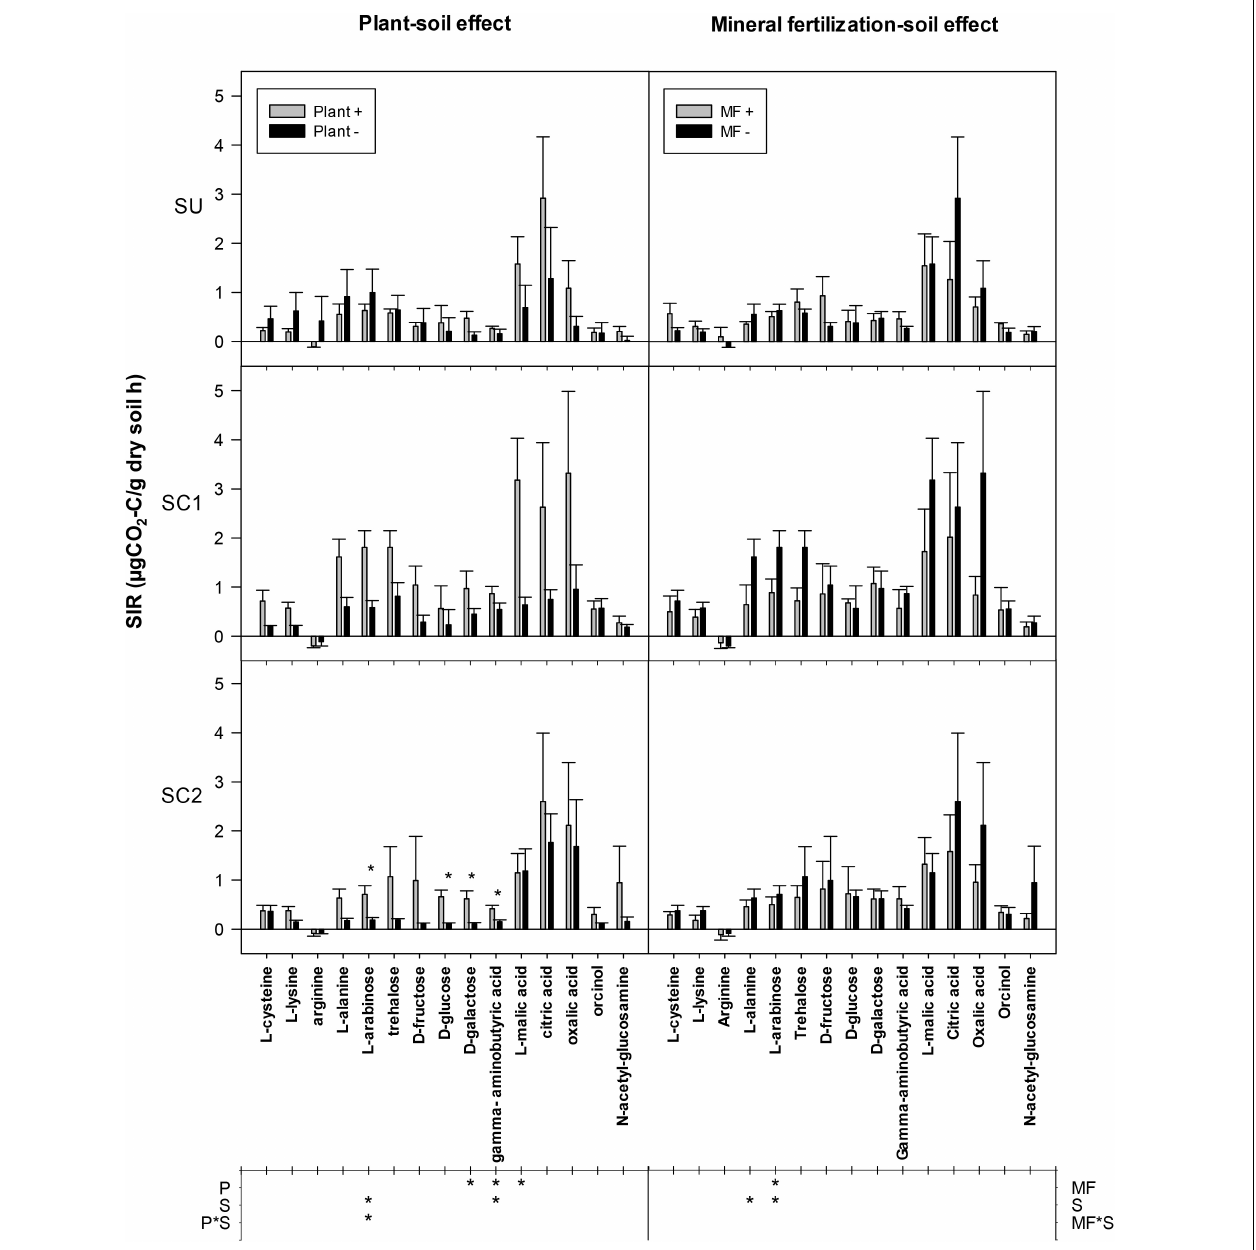
FIGURE 5 | Mean substrate-induced respiration (SIR) rates in response to the addition of 15 C substrates to soils from different treatments. The effects of the different soils (S, SC1, SC2) with (plant+) and without plant (plant-) are shown in the left column (plant–soil effect), while the effects of soils (S, SC1, SC2) and mineral fertilization (MF+, MF − ) are shown on the right (mineral fertilization–soil effect). Asterisks in the main plot indicate significance of the plant effects within each soil. The lower table indicates ANOVA significances with an asterisk for factors and interaction in each experiment. P refers to the plant effect, S to the soil effect (S), and P*S to the interaction between plant and soil. Error bars indicate standard error of the mean ( n =